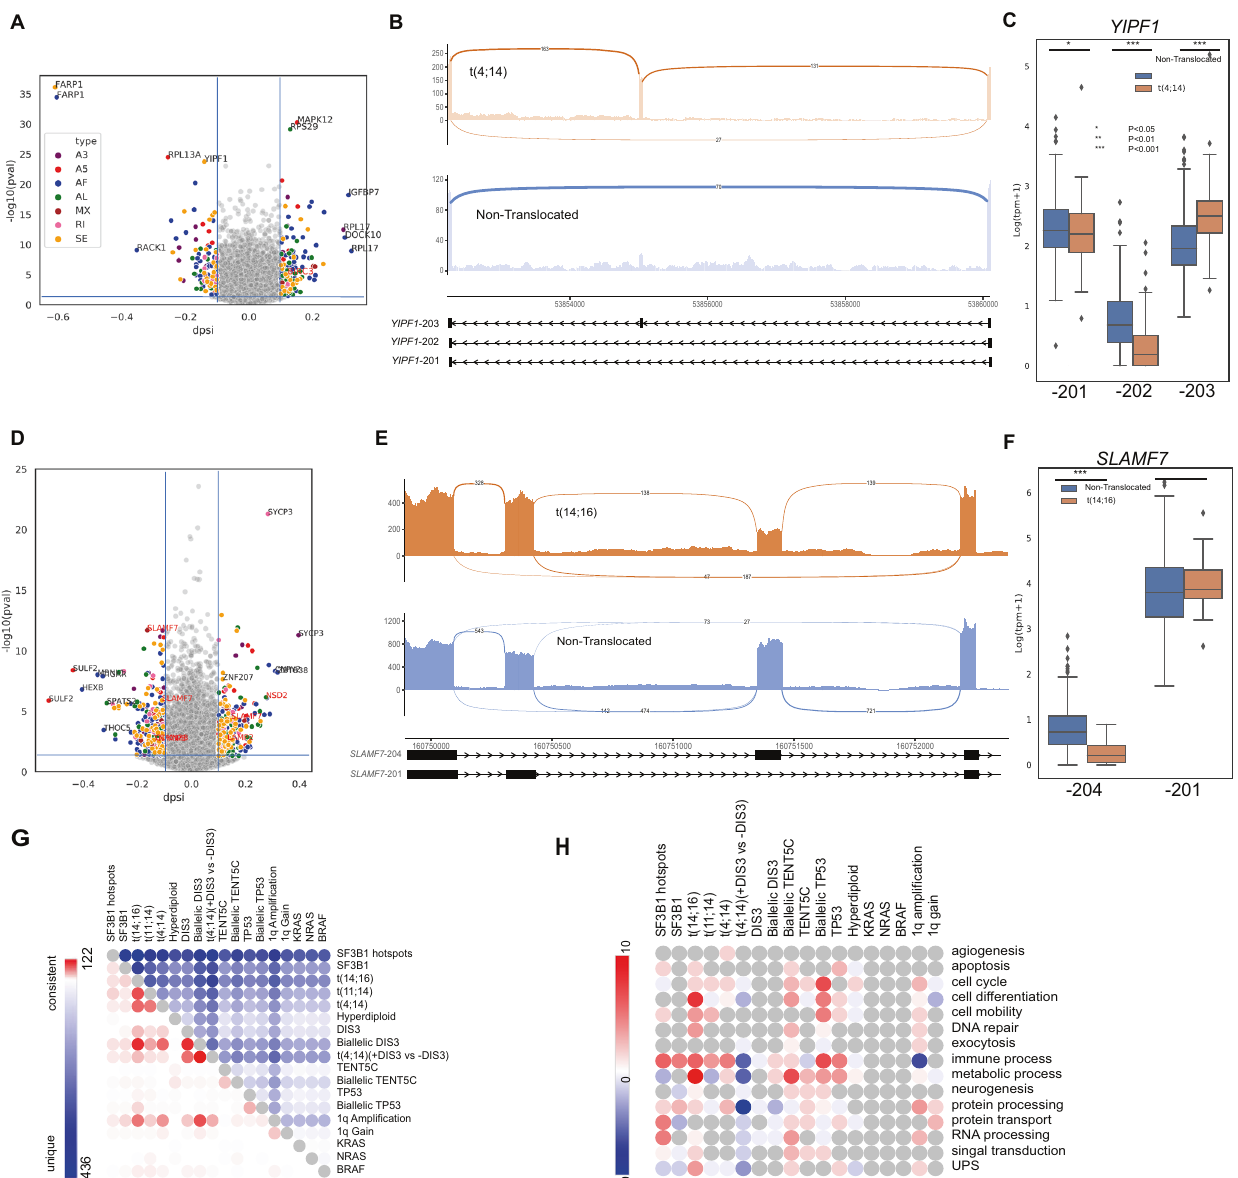
Fig. 2 Heterogenous nature of AS among cytogenetic groups. A , D Volcano plots of AS events in t(4;14) and t(14;16), respectively. Genes labeled in red indicate documented oncogenes in MM. B , E Examples of AS events in each translocation subgroup including a skipped exon in YIPF1 in t(4;14) and a mutually exclusive exon event in SLAMF7 in t(14;16). C , F Expression level of transcripts involved in AS events in ( B ) and ( E ). G Consistent (red) and unique (blue) AS events among 18 cytogenetic comparisons. H Upregulated (red) and downregulated (blue) pathways derived from AS comparisons. * P < 0.05; ** P < 0.01; *** P < Alternative splicing frequency is associated with the activity groups including metabolic process, immune process, and cell of the non-homologous end joining pathway mobility, even though most of the categories are upregulated in We speculated that spliceosome expression regulates the splicing t(14;16) and t(4;14) but inconsistently dysregulated in t(11;14). frequency of transcripts. For each genetic comparison, we t(14;16) contributes the most number of dysregulated pathways calculated the absolute log 2 (Fold-Change) of all spliceosome with cell differentiation and metabolic process being the most upregulated. genes and performed unsupervised clustering (Supplementary DIS3 abnormalities had a profound negative effect on many Fig. 6). Four heat shock proteins, HSPA1L , HSPA1A , HSPA1B , and HSPA6 , were clustered together, of which three correlated highly pathways with downregulation of genes. In particular, RNA processing pathways were downregulated across all DIS3 cate- with splicing frequency ( ρ > 0.65, Spearman correlation, Fig. 3A). gories. The combination of t(4;14) + DIS3 dysregulated the most All three genes encode proteins that belong to the Hsp70 protein pathways, all of which were downregulated (in comparison to family that contains various protein homologs, including Hsp73, t(4;14) without DIS3 mutation). Biallelic DIS3 contributed the Hsp70B ’ and Hsp72 [31]. Hsp73 is the constitutive form and is second most, which included immune and metabolic processes, encoded by the spliceosome gene HSPA8 [31]. Hsp72 (encoded by HSPA1A and HSPA1B ) and Hsp70B ’ (encoded by HSPA6 ) are RNA processing, and protein processing.